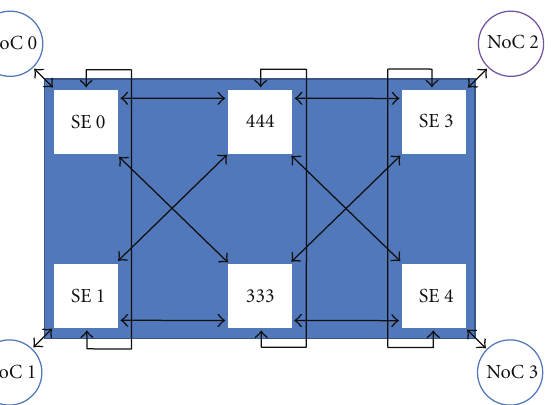
Figure 22: The simulation state of NiP-HXN model at third step of worst